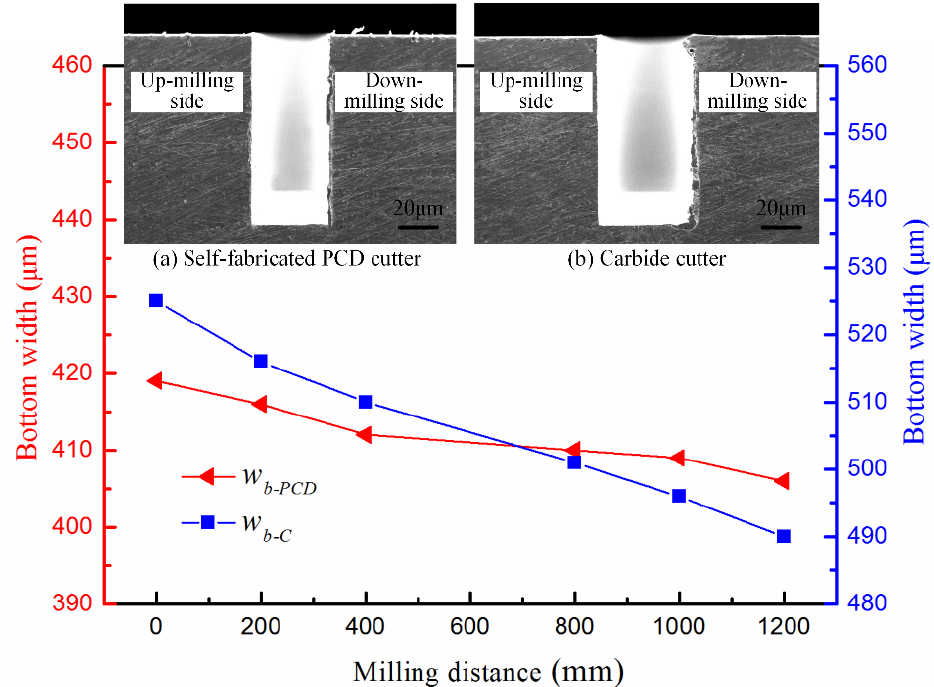
Figure 14. Variation of the bottom widths ( w b ) with the milling distance.